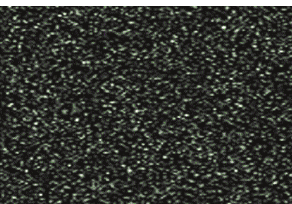
Figure 11: The encrypted image using the encryption method in fractional-order Chua system (4) as in Section